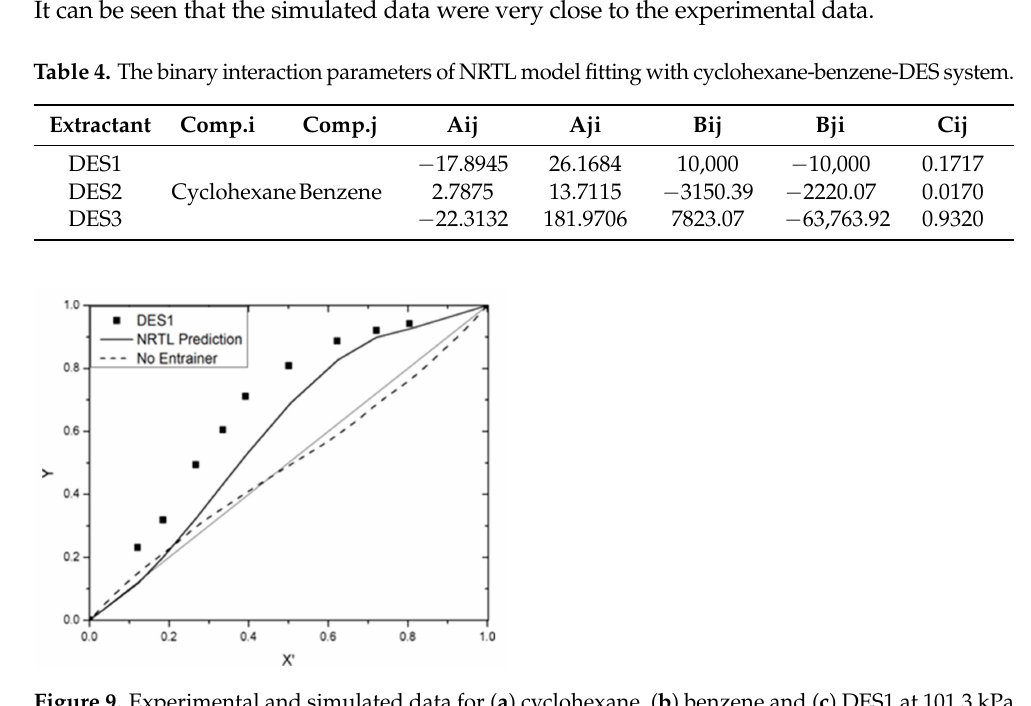
Figure 9. Experimental and simulated data for ( a ) cyclohexane, ( b ) benzene and ( c ) DES1 at 101.3 kPa for a DES molar fraction of 0.1.